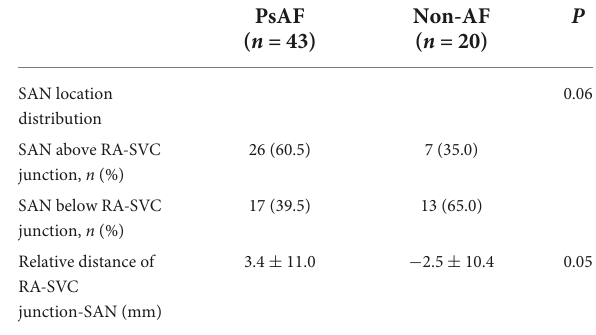
TABLE 7 Comparison of the distribution of EAA of SAN between PsAF and non-AF